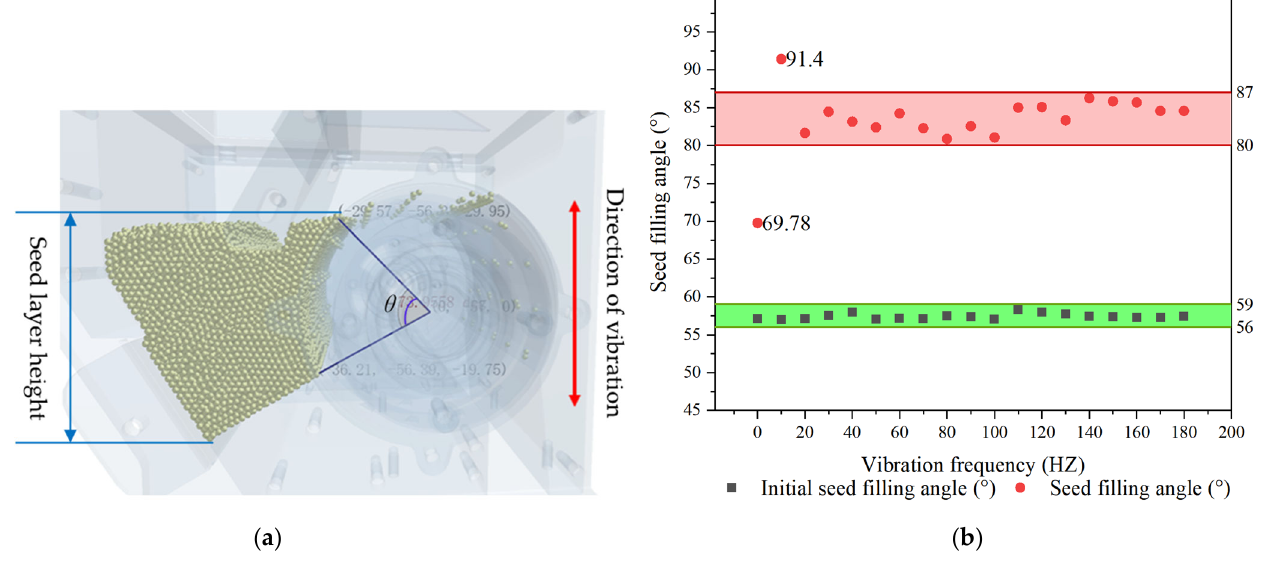
Figure 10. ( a ) Sketch map of seed ‐ filling angle ( θ ) and ( b ) effect of vibration on seed ‐ filling angle.